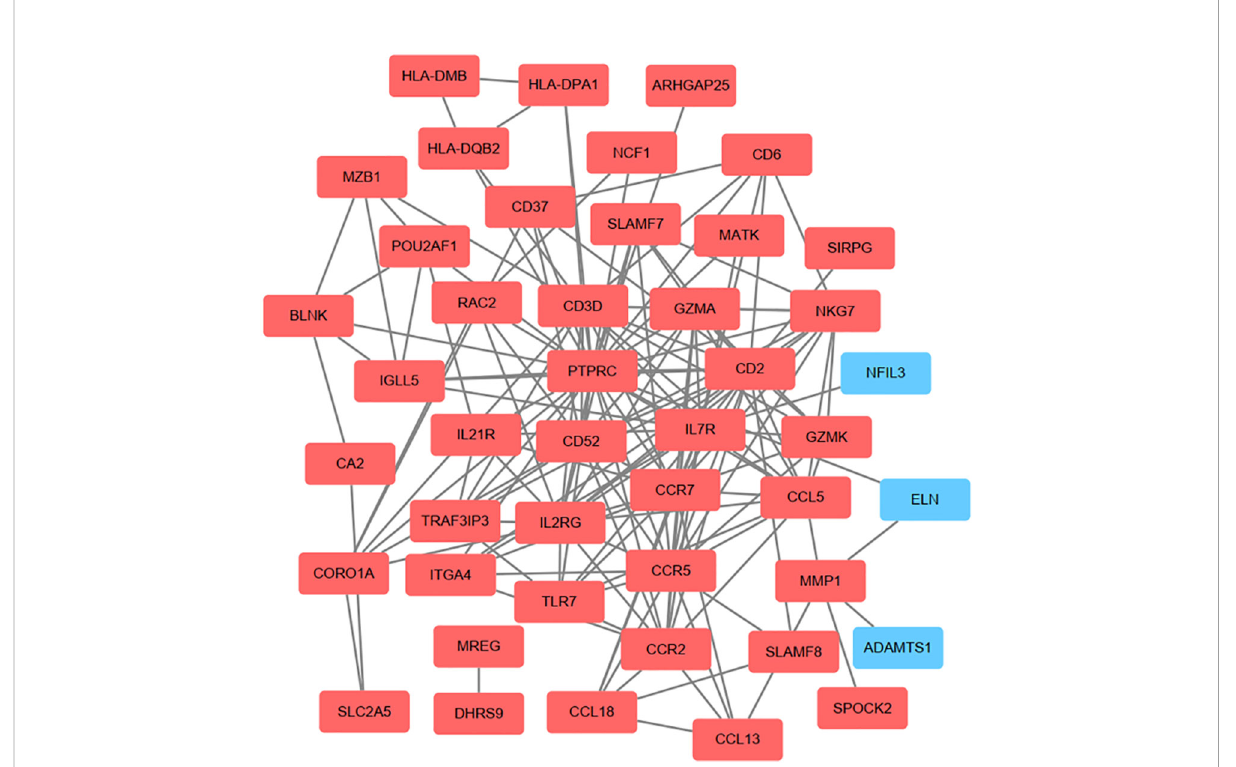
FIGURE 4 On the ground of STRING database, PPI networks of the communal DEGs were constructed by Cytoscape software. The red round rectangle represents upregulated genes and the blue round rectangle represents downregulated